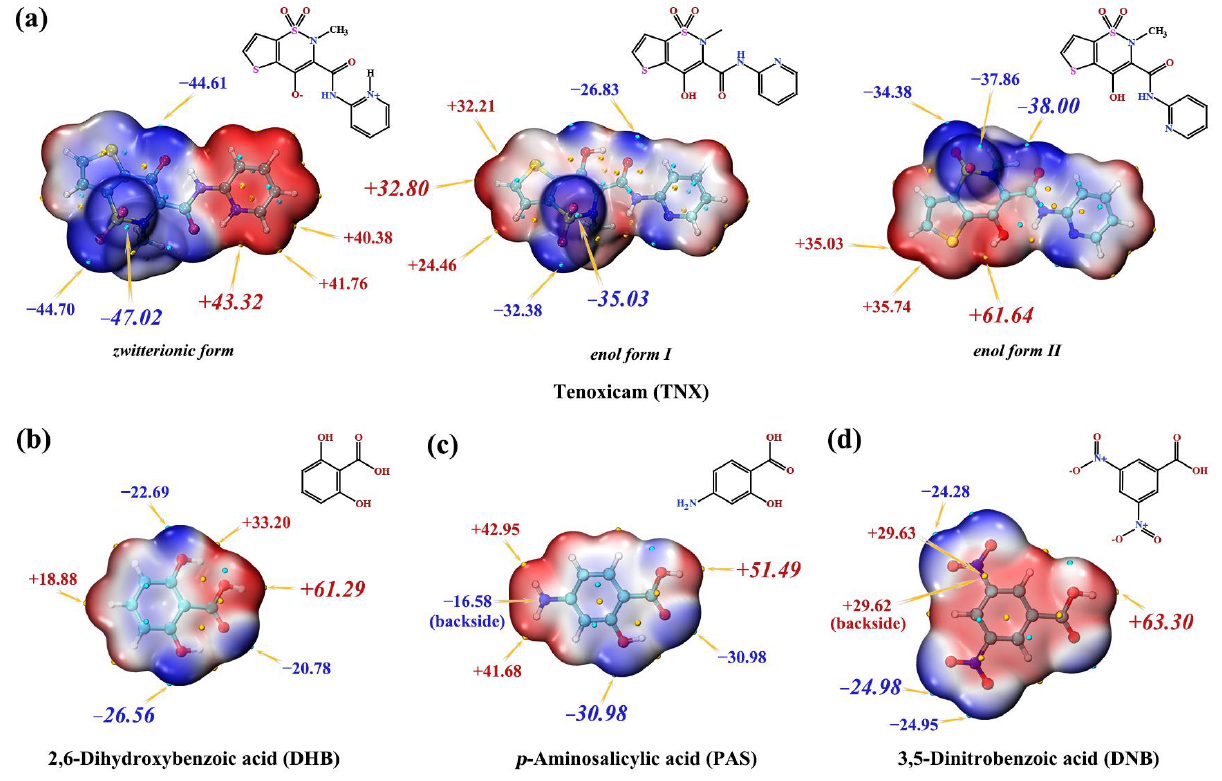
Figure 1. Molecular structures and MEPS of API ( a ) and CCFs ( b – d ).